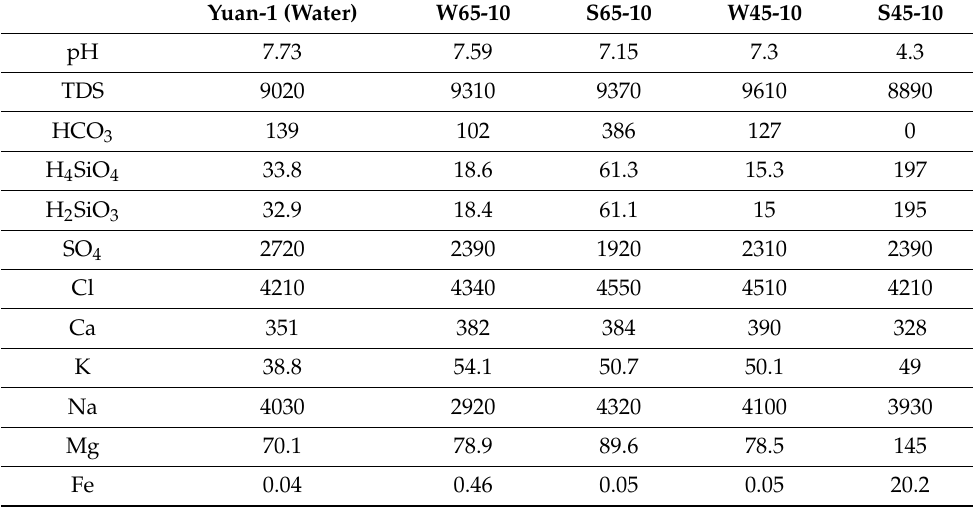
Table 3. Contents of major elements in geothermal water before and after water–rock